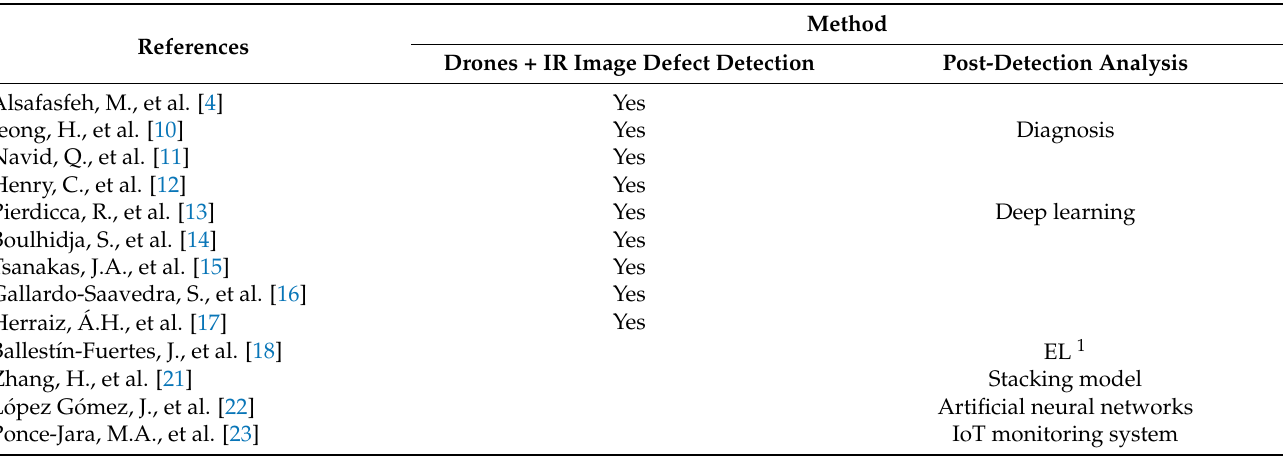
Table 1. A comparison of references related to solar panel monitoring using